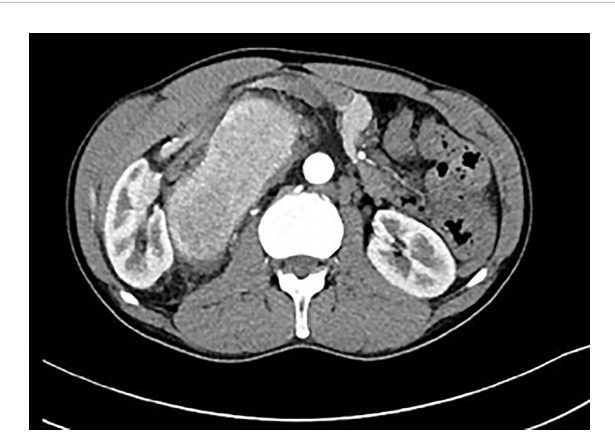
FIGURE 7 Postcontrast CT of unicentric form of Castleman disease. Markedly enhanced mass in right retroperitoneal space displacing right kidney.